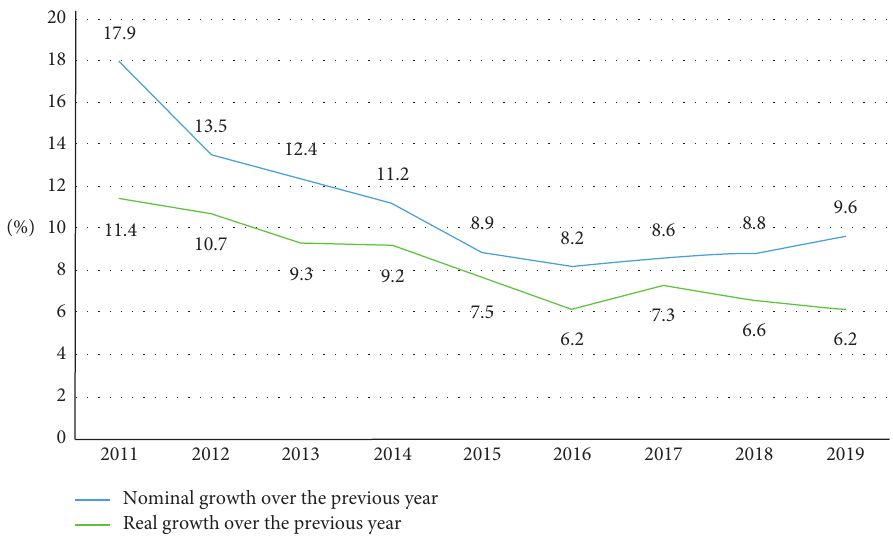
Figure 1: Growth rate of per capita disposable income in rural area of